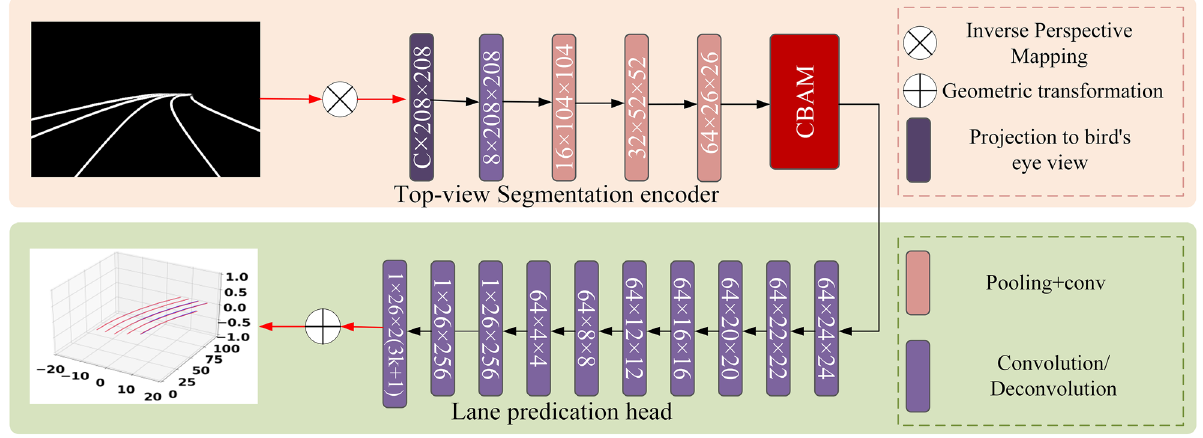
Figure 7. The architecture and composition of the Geometric encoding